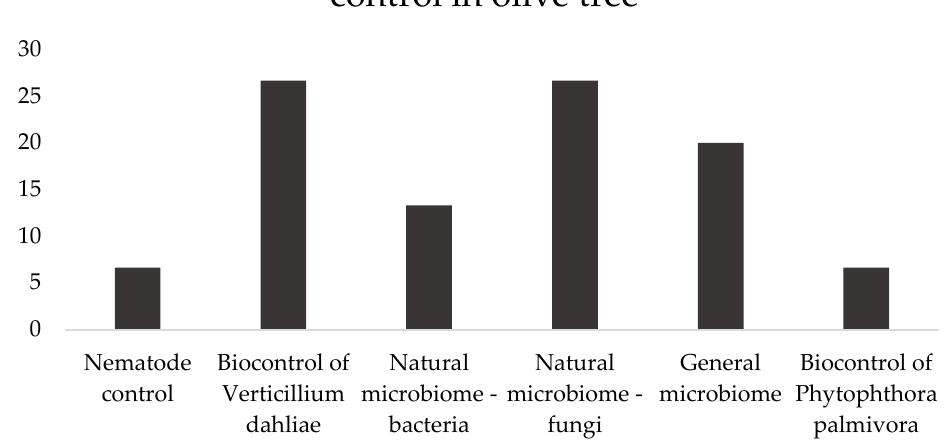
Figure 2. Subjects covered in the selected papers, in percentage, addressing the relation between microorganisms and disease control in olive tree, between brackets. Nematode control [51], Biocontrol of Verticillium dahlia [52,53,61,62], Natural microbiome—bacteria [54,59], Natural microbiome—fungi [55–58]. General microbiome [2,6,63], Biocontrol of Phytophthora palmivora